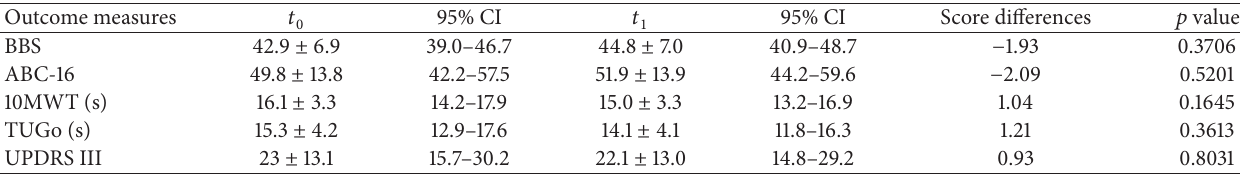
Table 3: Functional findings of 15 patients with Parkinson’s disease at baseline ( 𝑡 0 ) and at the end of the 8-week program of action observation treatment (AOT) ( 𝑡 1 ). Data are presented as mean ± standard deviation (SD) and 95% confidence interval (95%